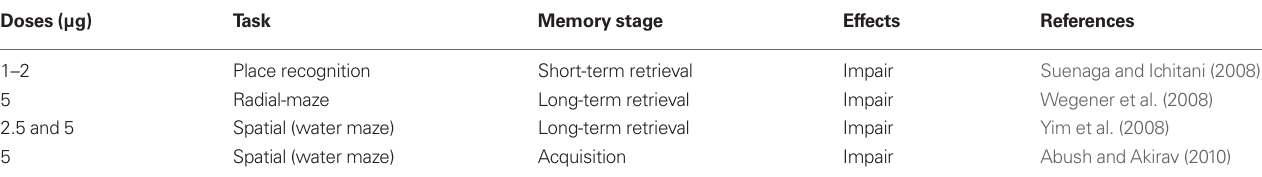
Table 1 | Effects of intra-dorsal hippocampal WIN 55,212-2 on learning and memory. Doses